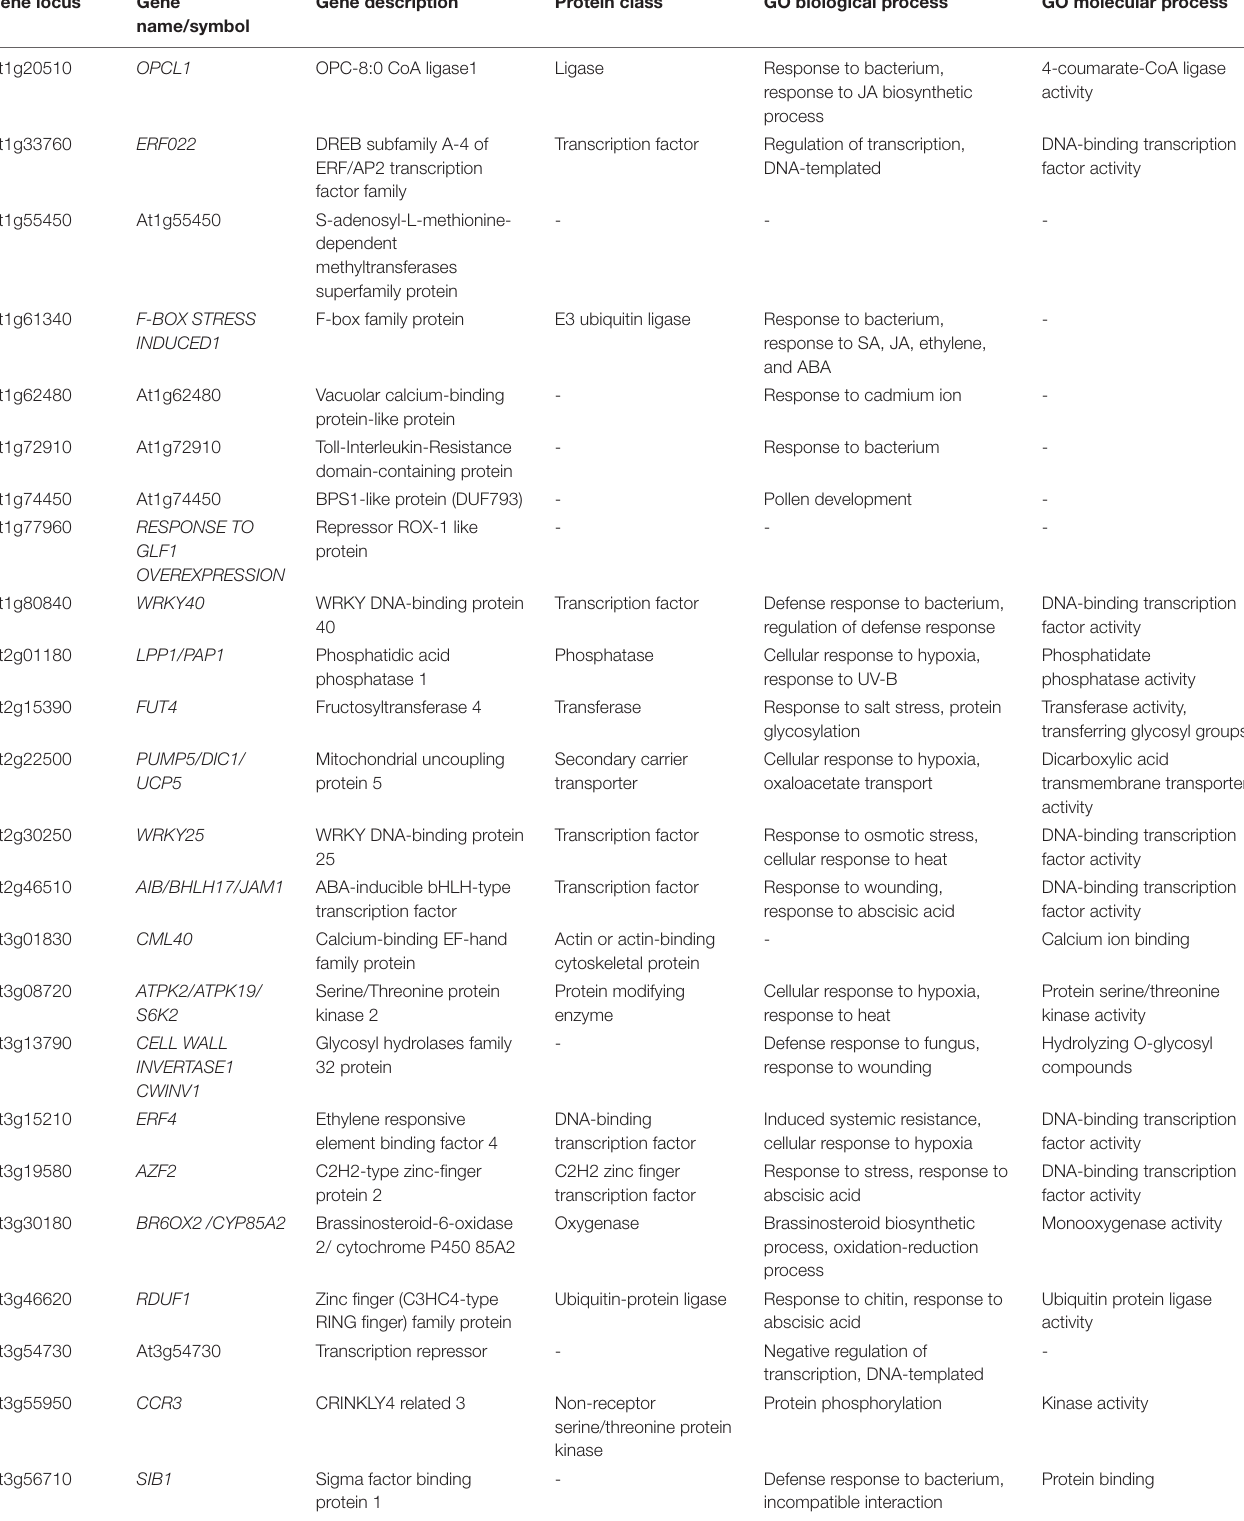
TABLE 1 | List of DEGs in ldl1 ldl2 mutants overlapping with putative LDL1 target genes described by Hung et al. (2018). Gene